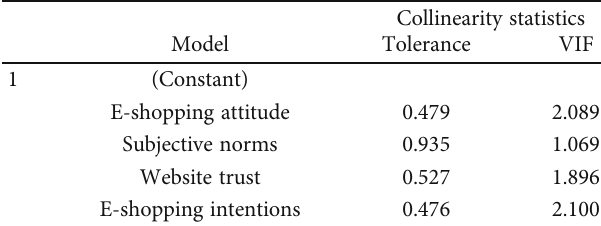
Table 8: Multicollinearity